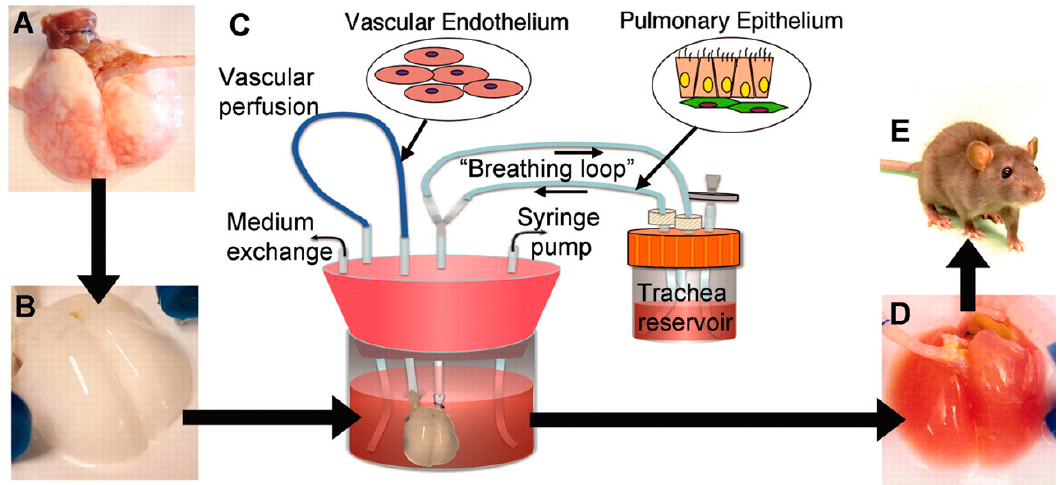
Figure 3. Scheme for lung tissue engineering [89]. ( A ) Native adult rat lung is cannulated in the pulmonary artery and trachea for infusion of decellularization solutions. ( B ) Acellular lung matrix is devoid of cells after 2 to 3 h of treatment. ( C ) Acellular matrix is mounted inside a biomimetic bioreactor that allows seeding of vascular endothelium into the pulmonary artery and pulmonary epithelium into the trachea. ( D ) After four to eight days of culture, the engineered lung is removed from the bioreactor and is suitable for implantation into ( E ) the syngeneic rat recipient. (Reprinted with permission from the American Association for the Advancement of Science (AAAS)).